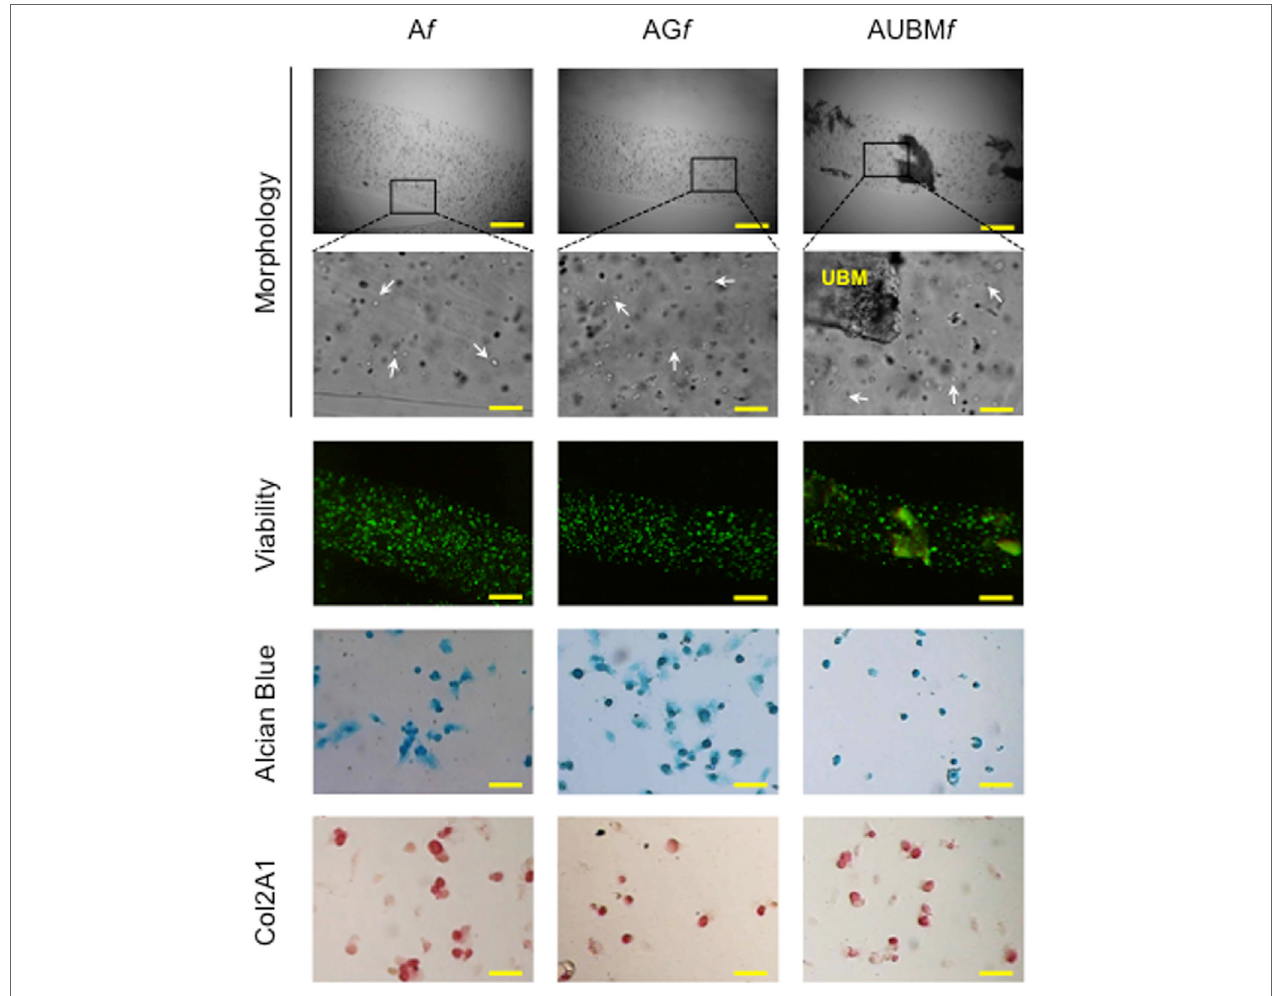
FigUre 8 | Cryopreservation of Af, AGf , and AUBMf embedded cells. A f , AG f , and AUBM f embedded redifferentiated chondrocytes were frozen, stored in liquid nitrogen, thawed, and assessed for cell morphology, viability, and chondrogenic properties. Optical images of microfibers show the rounded shape retention by the thawed embedded cells (particularly evident at higher magnification: see white arrows). Fluorescence merged images of the Calcein-AM (green)/propidium iodide (red) double staining demonstrated the high cell viability. The presence of GAGs and Col2A1 was detected by Alcian Blue staining and immunocytochemical analysis on the thawed embedded cells recovered from microfibers and grown in monolayer for 24 h. Bar corresponds to: 300 µm in lower magnification images of morphology and viability, 60 µm in higher magnification, and 50 µm in Alcian Blue staining and Col2A1 immunocytochemical